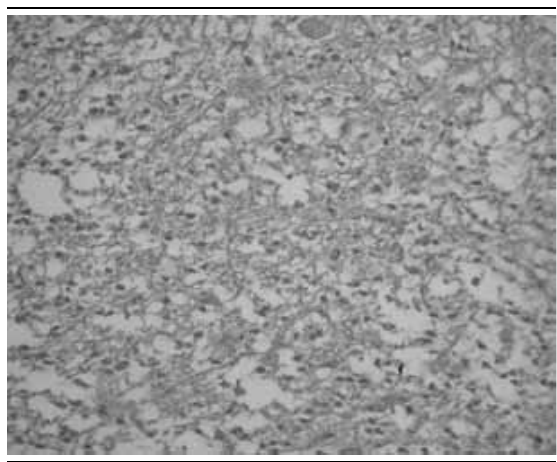
figurE 4 – Pilocytic astrocytoma showing positive immunoexpression for GFAP, streptavidin-biotin, 200× GFAP: glial fibrillary acidic